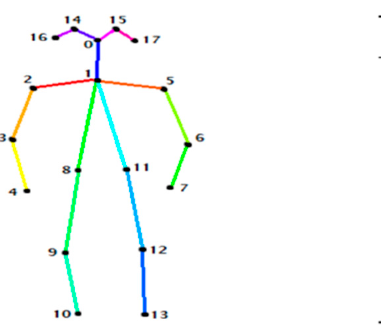
Figure 3. OpenPose Skeleton data and joints information.